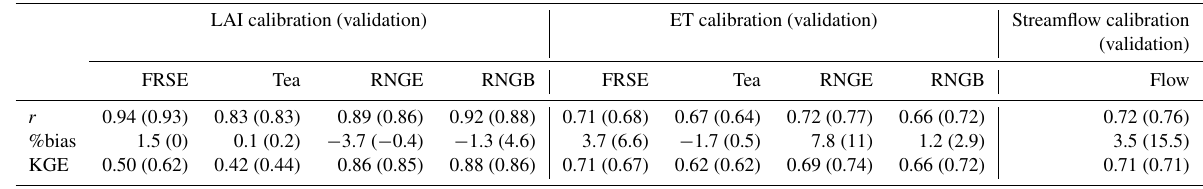
Table 3. Summary of the performance metrics for the SWAT-T for simulating LAI, ET and streamflow. Note that the performance for LAI and ET refers to 8-day aggregated data, whereas daily streamflow data are considered.